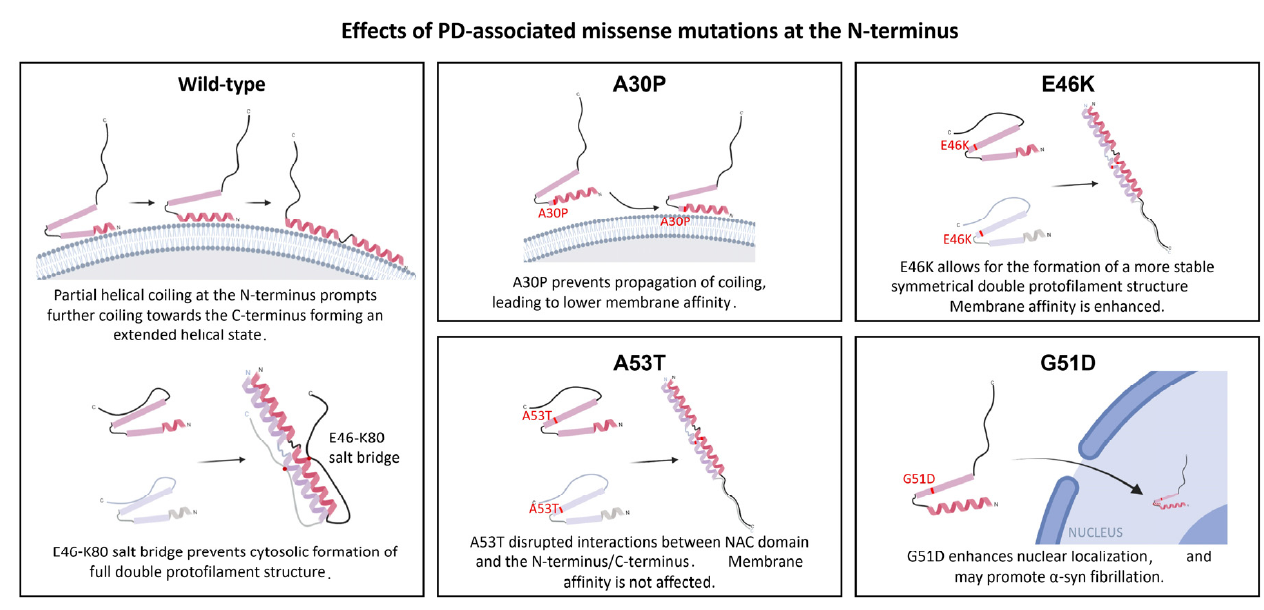
Figure 1. Effects of missense mutations on the α -syn structure and physiological functions. A30P may prevent further helical coiling of α -syn helical domain [32,33], reducing α -syn membrane- binding affinity [78,79], and allowing its aggregation within the cytosol E46K removes the salt bridge formation between E46 and K80, allowing the formation of stable protofilament that promotes further fibrillation [80]. Similarly, A53T interrupts distant NAC and N-terminal or C-terminal interactions, leading to protofilament formation [82]. G51D mutations promotes the nuclear localization and hyperphosphorylation of S129 that induces aggregation [59]. Figure is created with